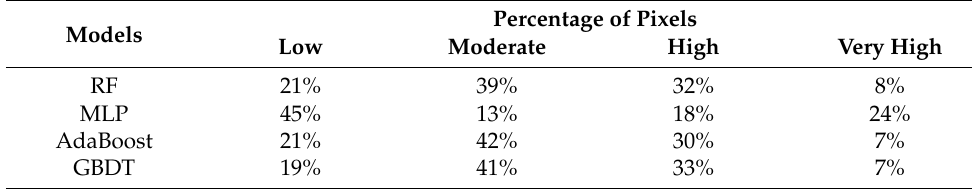
Table 6. Estimated landslide susceptibility based on the four